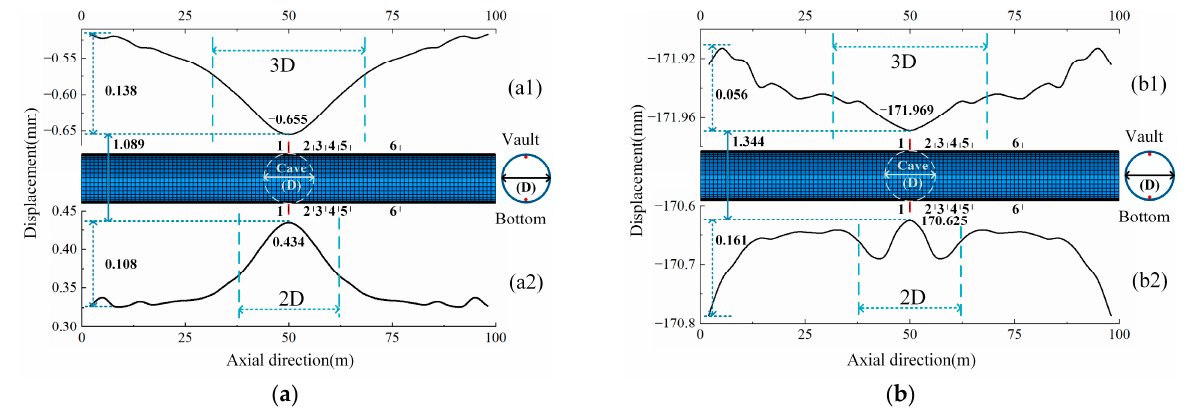
Figure 7. Vertical displacement of the tunnel’s vault and bottom: ( a ) the displacement of the vault and bottom at incident angle of 0° ((a1) displacement of vault, (a2) displacement of bottom) and ( b ) the displacement of the vault and bottom at incident angle of 30° ((b1) displacement of vault, (b2) displacement of bottom).